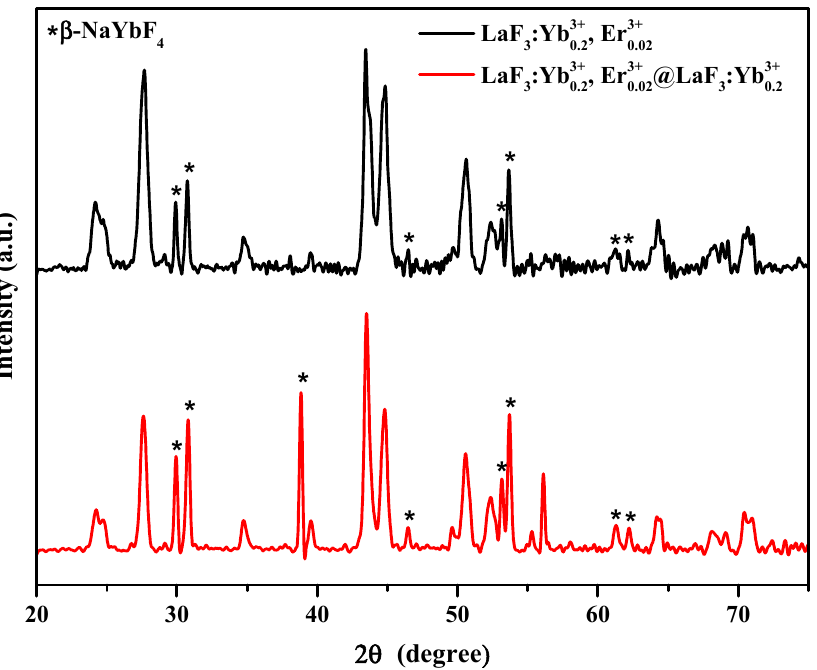
Figure 6. X-ray diffraction patterns for the as-synthesized LaF 3 :Yb 3+0.20 , Er 3+0.02 core UCNPs and LaF 3 :Yb 3+0.20 , Er 3+0.02 @LaF 3 :Yb 3+0.20 core/shell UCNPs (*: β -NaYbF 4 crystals).